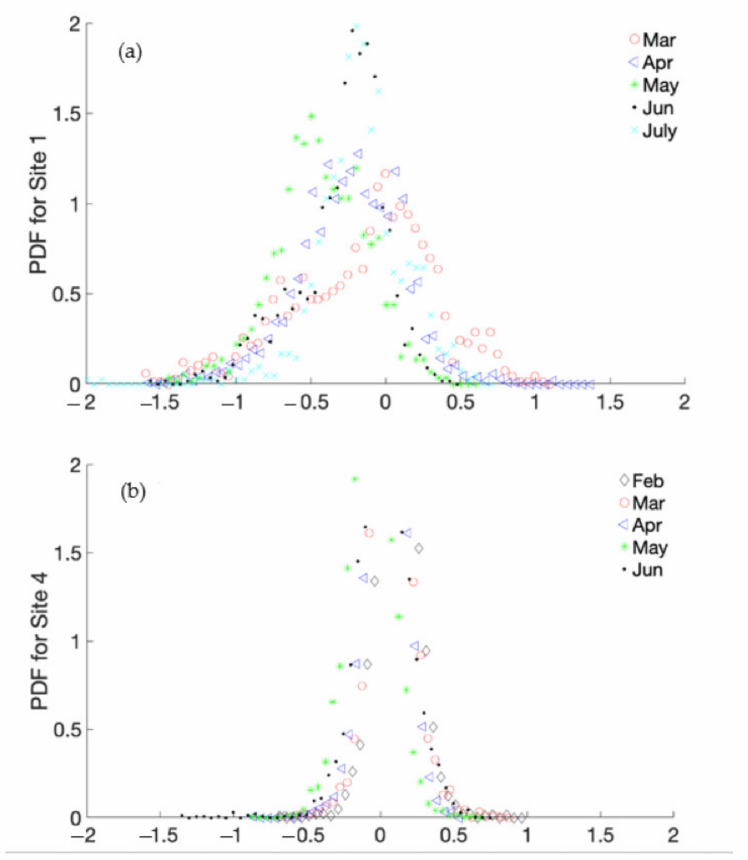
Figure 8. Probability density function (PDF) of modelling errors for sites 1 ( a ) and 4 ( b ), used for calibrating residential and collector sewer models,